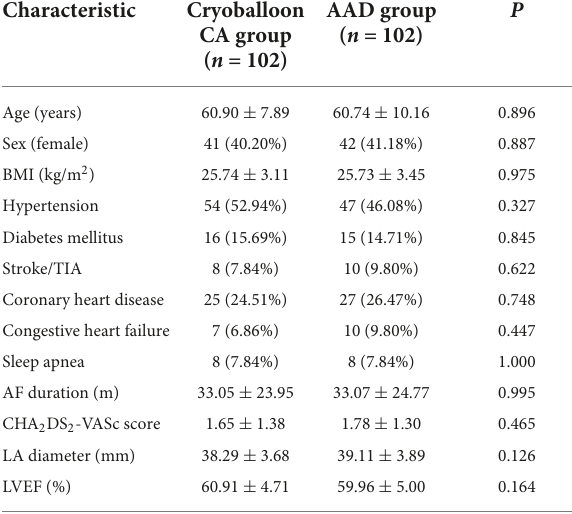
TABLE 1 Baseline characteristics of the patients (ITT